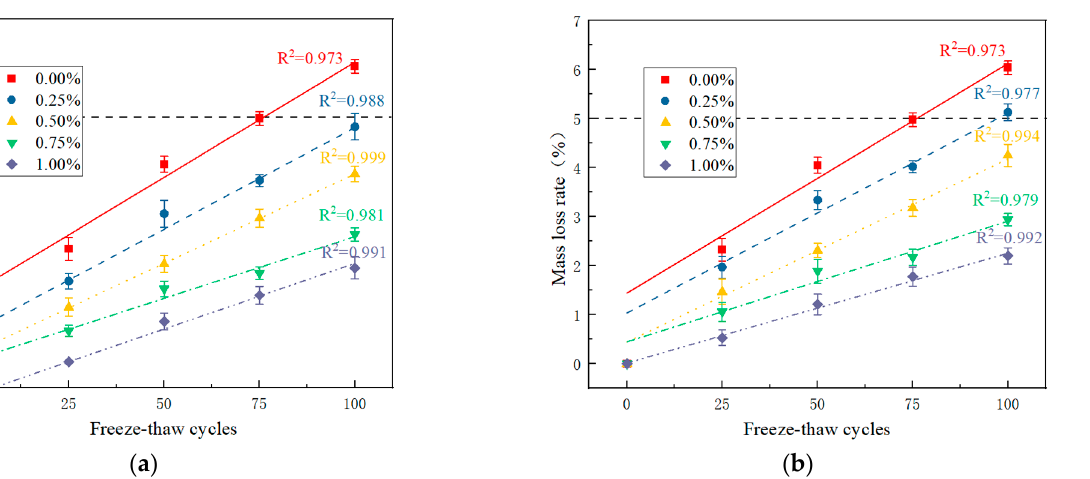
Figure 6. Fitting curve of mass loss rate of PRGRC with the number of freeze-thaw cycles: ( a ) 6 mm POM fiber; ( b ) 12 mm POM fiber.